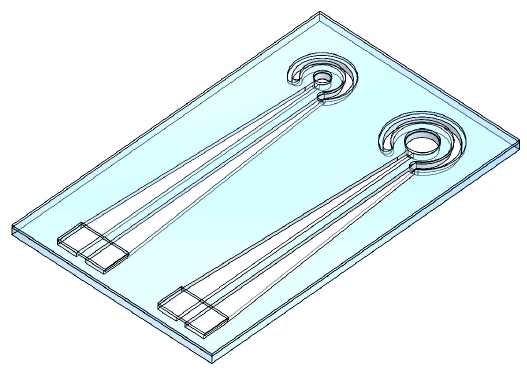
Figure 3. Conceptual drawing of the flexible electrode.